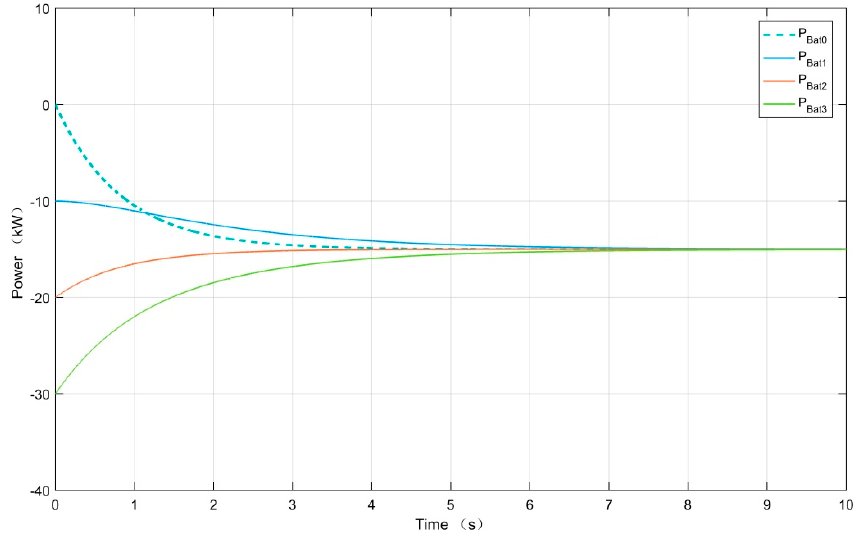
Figure 8. Battery power in modules.